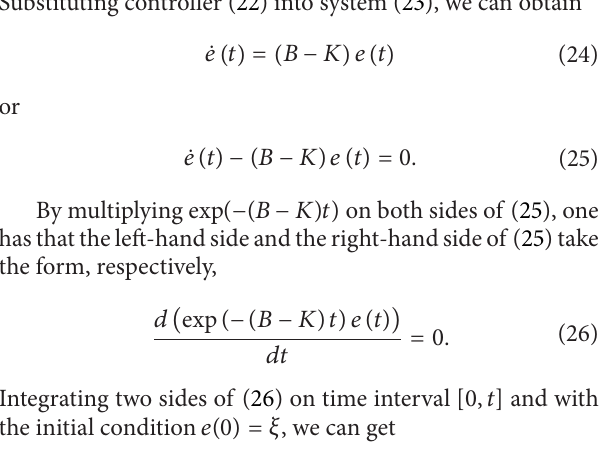
+ 𝑢 + 𝑢 = 0 ; 𝑢 = 0 ; 𝑢 = 0 ; 𝑢 = 0 4 5 6 3 2 1